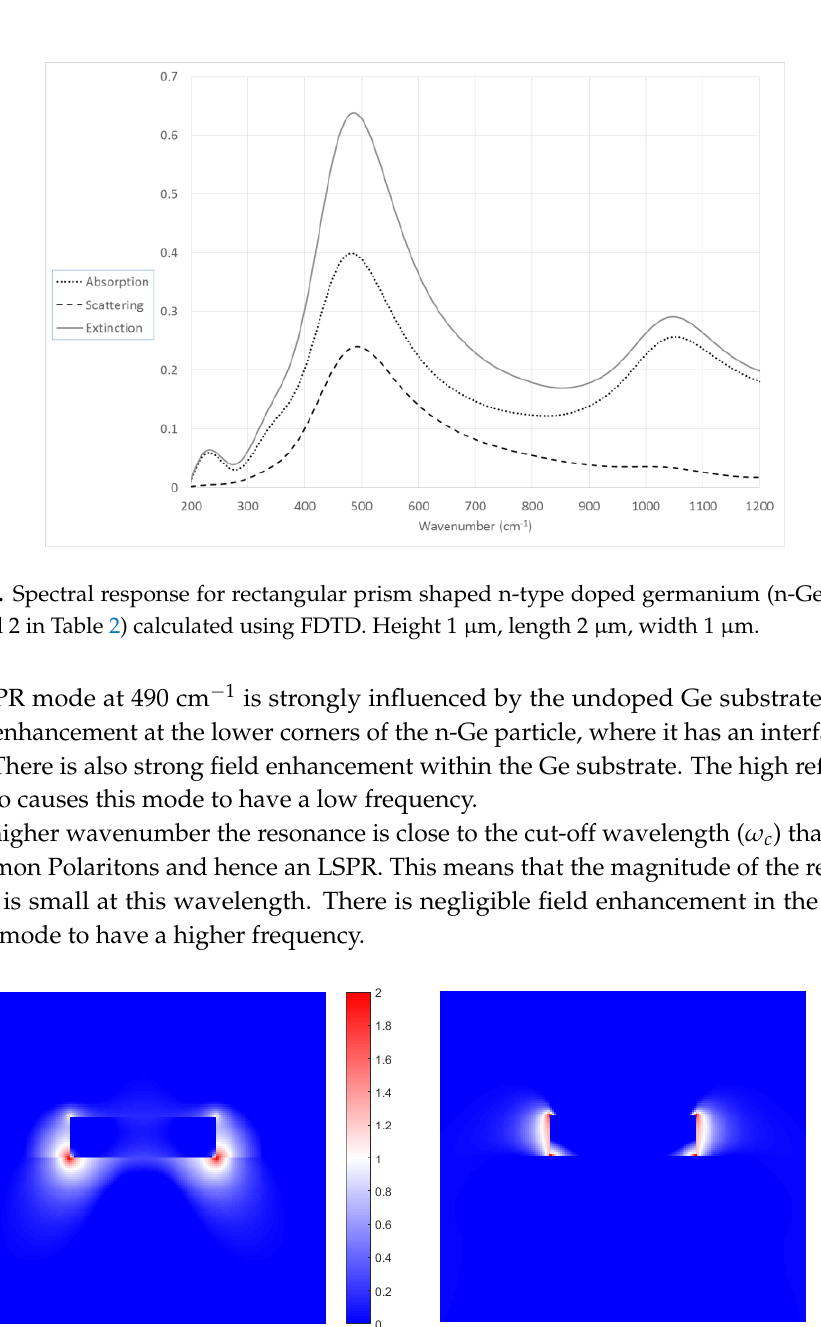
Figure 3. Spectral response for rectangular prism shaped n-type doped germanium (n-Ge) particle (material 2 in Table 2) calculated using FDTD. Height 1 μm, length 2 μm, width 1 μm.